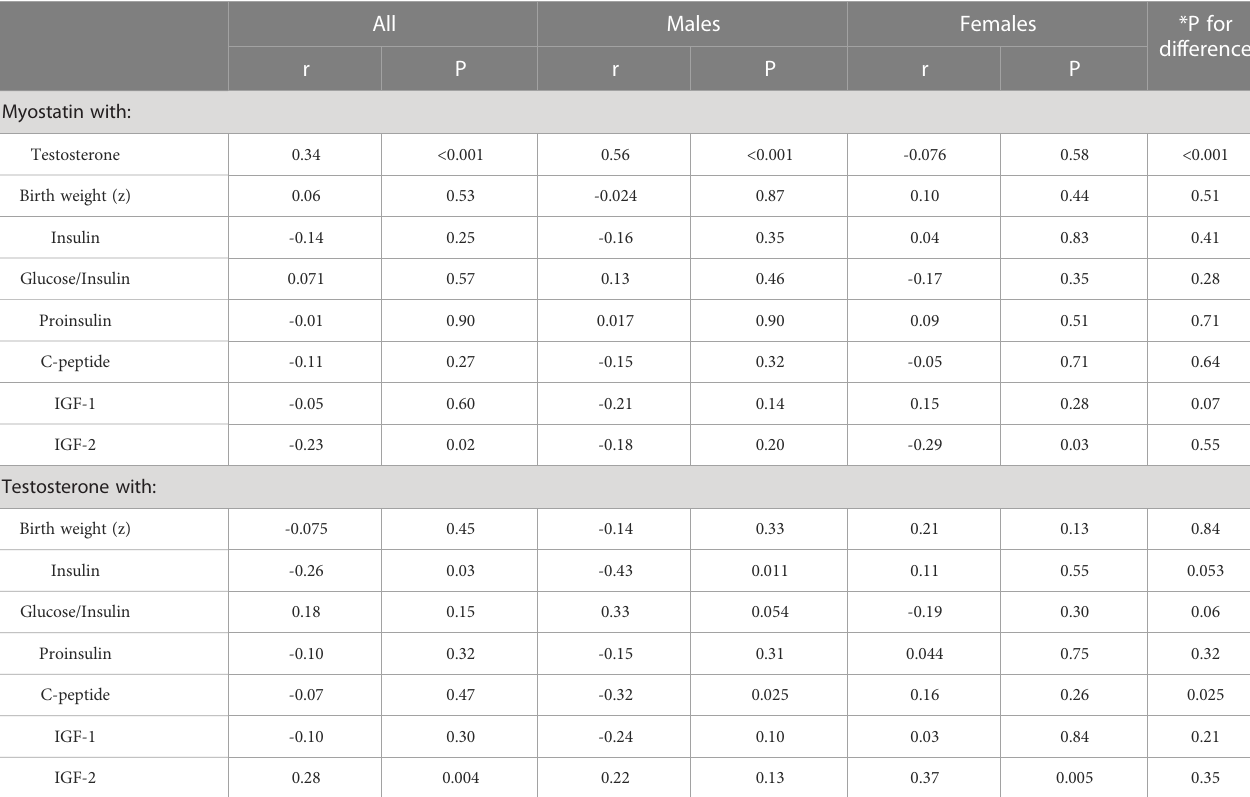
TABLE 5 Correlations of cord blood myostatin with testosterone, birth weight (z), glucose/insulin ratio and fetal growth factors. All Males Females *P for